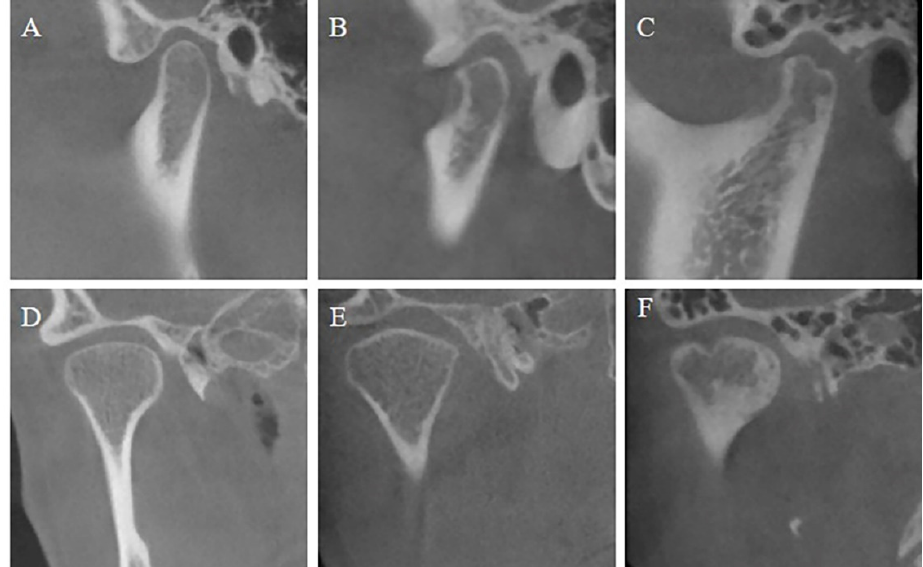
Figure 1. CBCT images of representative examples of condylar bony changes. ( A ) Sagittal view of normal condyle; ( B ) sagittal view of condyle with articular surface flattening; ( C ) sagittal view of condylar bony deformation; ( D ) coronal view of normal condyle; ( E ) coronal view of condyle with articular surface flattening; ( F ) coronal view of condylar bony deformation.